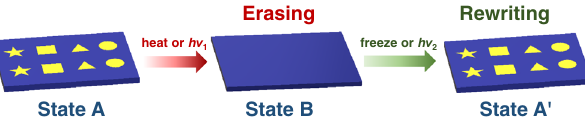
Fig. 1 Diagram of domains changes by heat and light. The erasing and rewriting process of ferroic domains controlled through temperature or light irradiation. The different shapes marked with yellow color denote the domains.